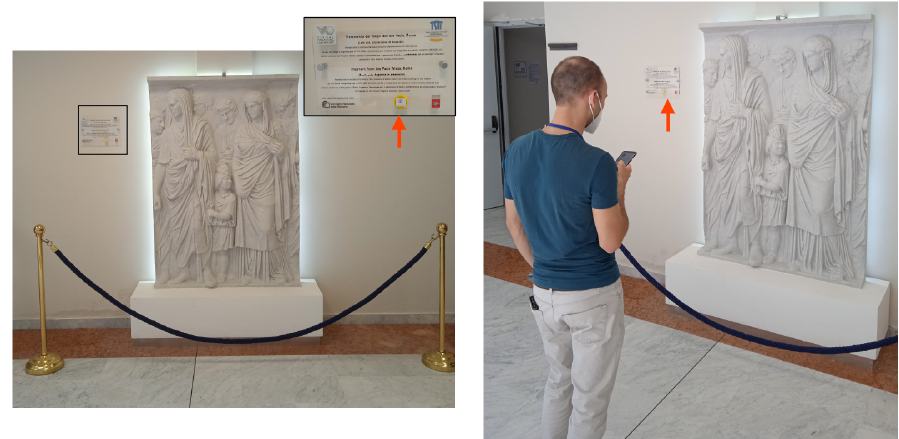
Figure 14. Artwork visit and deployment of a BLE tag in Pilot